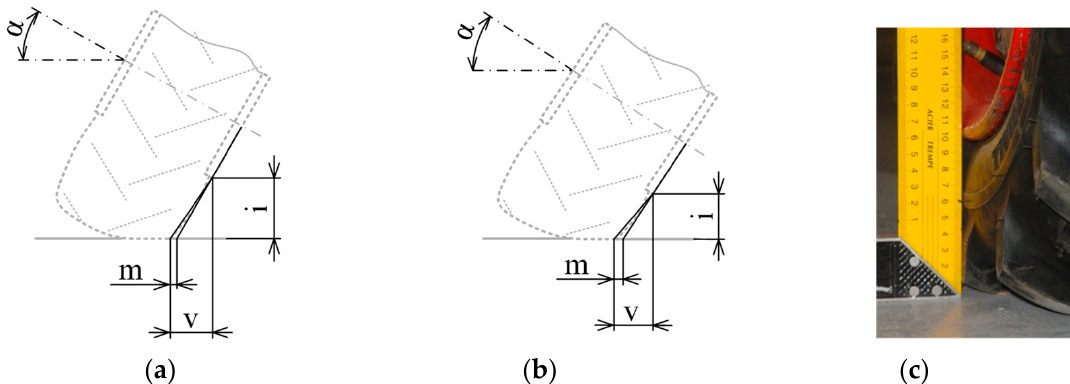
Figure 6. Determination of tyre shift due to lateral tyre deformation: ( a ) no rear wheel ballast weight, ( b ) highest rear wheel ballast weight, ( c ) vertical line of the steel set square touching corner of the tyre-tread pattern and wheel rim.